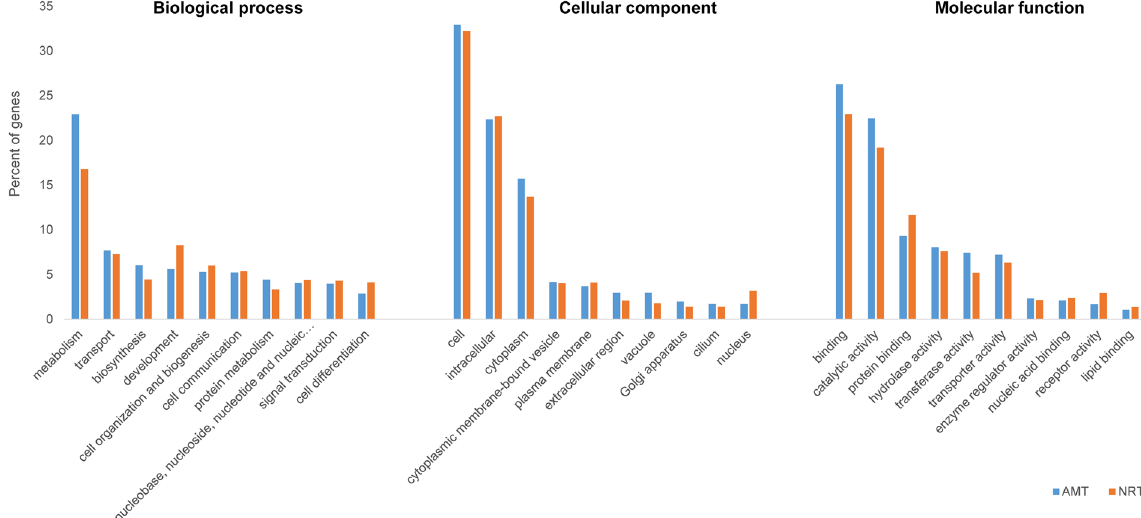
Figure 3. Distribution of differentially expressed wheat ammonium (wAMT) and nitrate (wNRT) transporter genes in three GO categories: biological process, cellular component, and molecular function. Only the top 10 GO terms in each category are displayed.